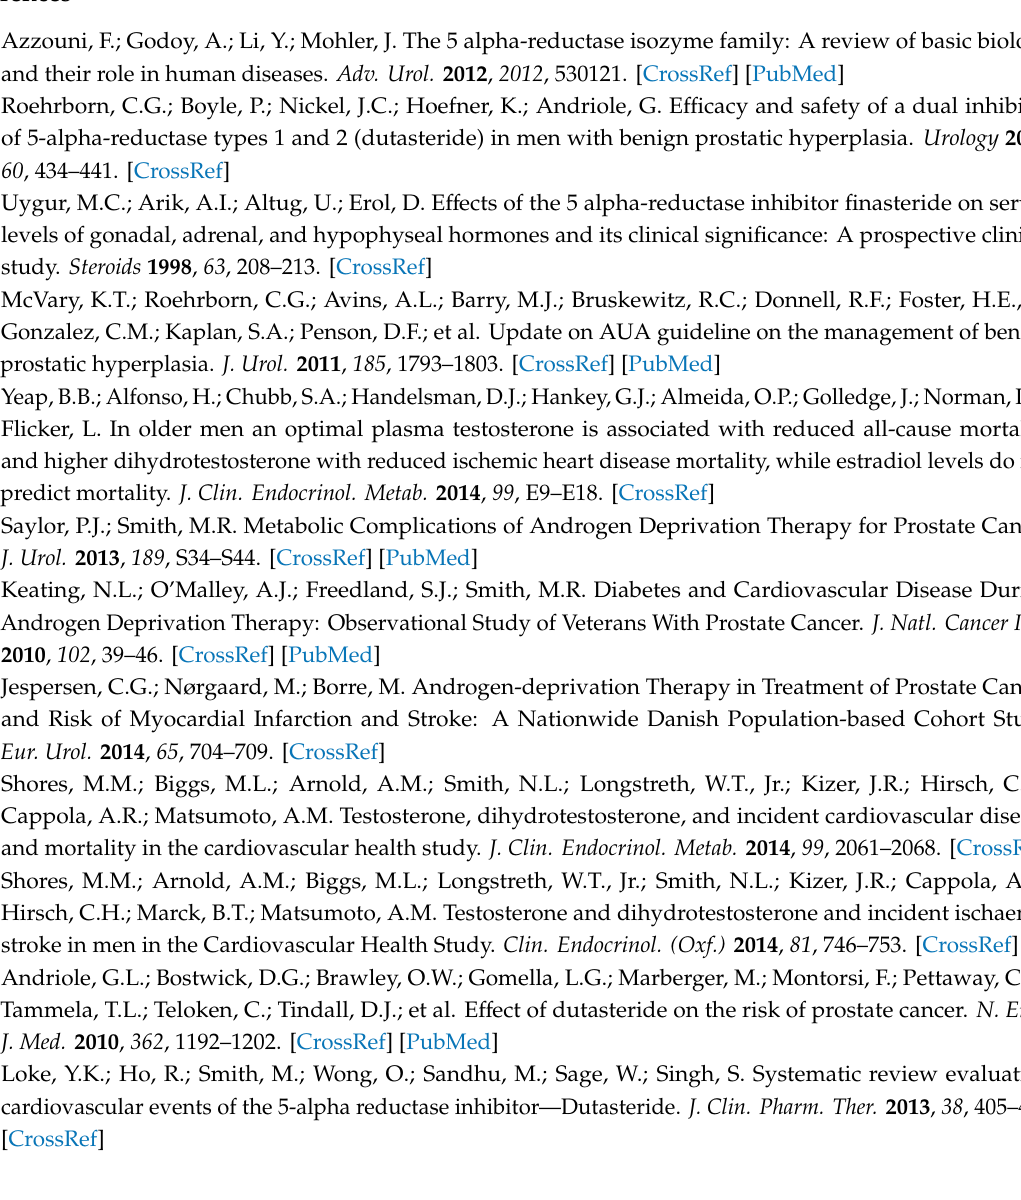
Supplementary Table S1: Summary of definitions of outcomes, exclusion criteria, and comorbidities., Supplementary Table S2: Hazard ratios of 5ARI users vs. non-users after stratification by cardiovascular risk factors, Supplementary Table S3: Hazard ratios of tertiles of 5ARI users vs. non-users, Supplementary Figure S1: Diagram of the male cohort and benign prostatic hyperplasia subcohort study